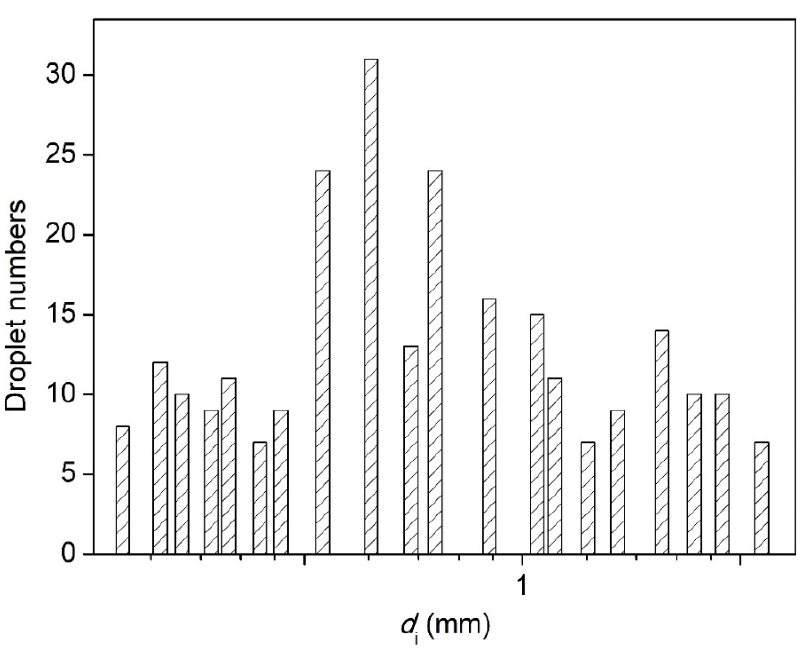
Figure 9. Pictures of electrostatic breakup of H 2 O 2 ligaments and droplet formation at different noz ‐ zle sizes (flow rate of 500 mL/h, voltage of 28 kV, 35 wt. % concentration).